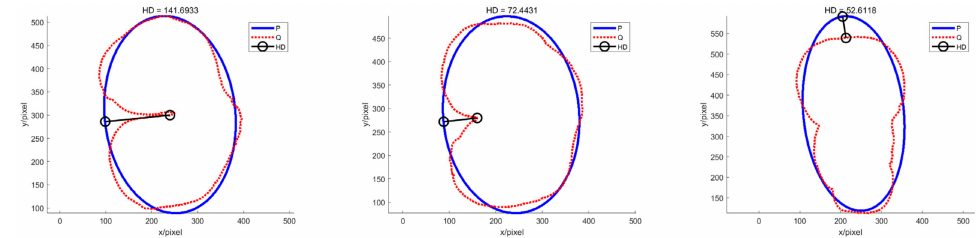
Figure 15. Hausdorff distance values of irregular potatoes from different